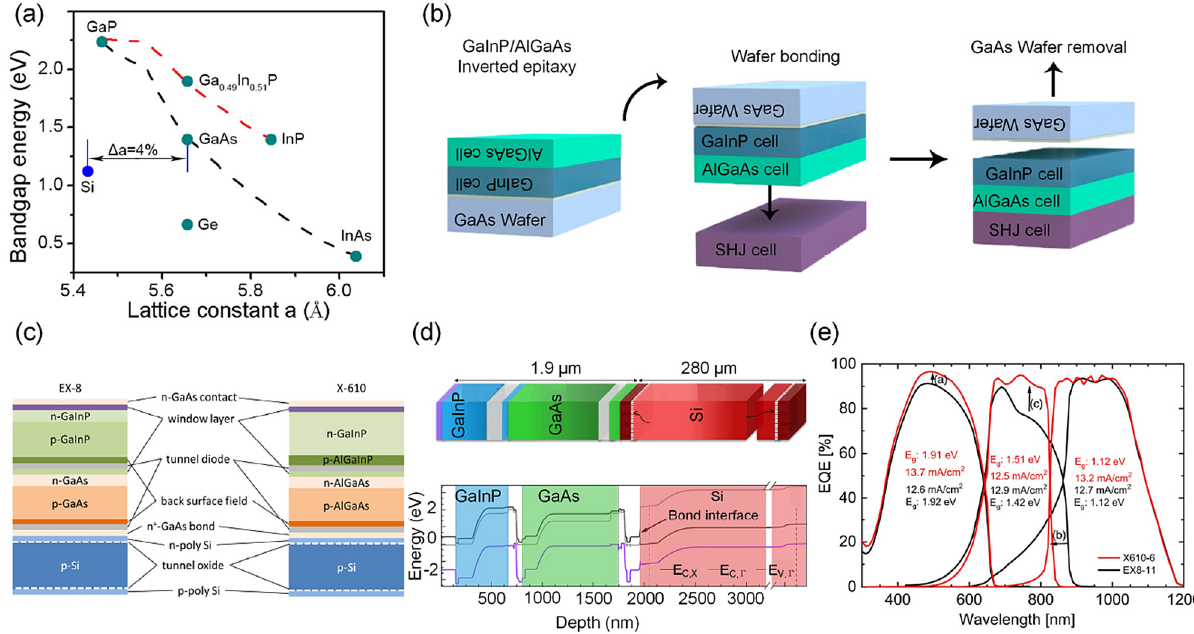
Figure 7: (a) Bandgap energy as a function of lattice constant for silicon, germanium and III – V semiconductors. Different strategies to overcome the difference of 4% lattice constant between GaAs and Si [36]. Copyright 2018, Elsevier. (b) Typical wafer bonding process of a 2T GaInP/AlGaAs/Si triple junction tandem device [132]. (c) The comparison of inverted grown EX-8 and “ upright grown ” X-610 GaInP/ AlGaAs(GaAs)/Si triple junction solar cells [47]. Copyright 2020, John Wiley and Sons. (d) Layer stack and bandstructure of a 2T Ga 0.51 In 0.49 P/ GaAs/Si solar cell [45]. E V , Γ (purple line), E C , Γ (direct transition, grey line), and E C , x (indirect transition, black line) are shown in band structure underopen-circuit conditionwithoutillumination[45].Copyright 2018,SpringerNature.(e)MeasuredEQEspectraof invertedgrownEX-8and “ upright grown ” X-610 GaInP/AlGaAs(GaAs)/Si triple junction solar cells [47]. Copyright 2020, John Wiley and